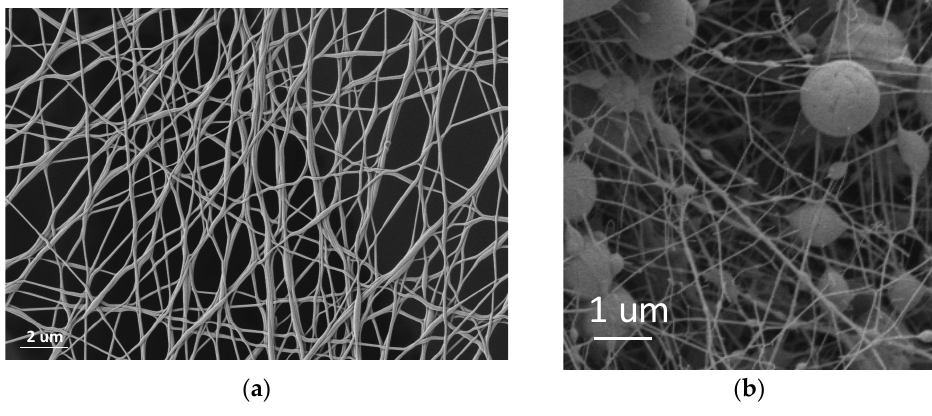
Figure 4. PVA nanofiber veil. ( a ) PVA 5 K; ( b ) PVA + 4% sage essential oil 5 K.